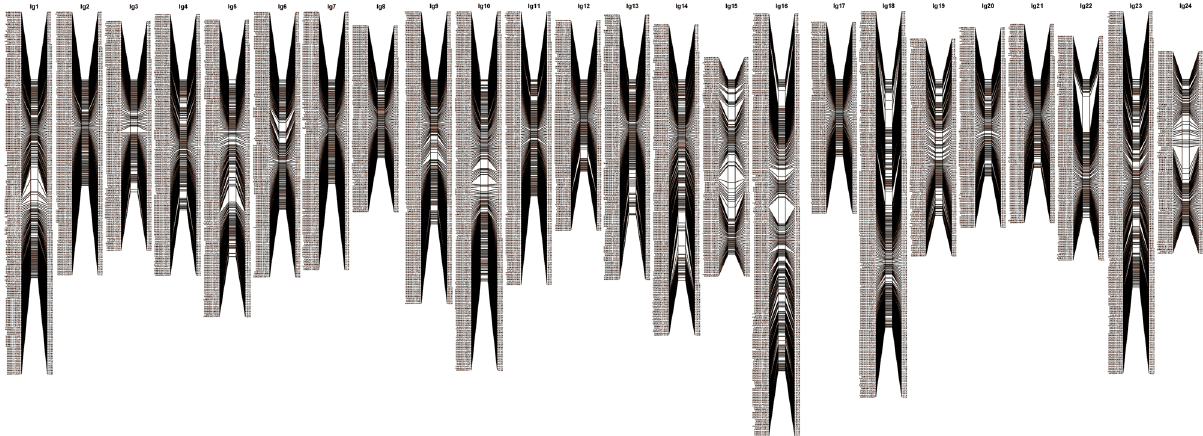
Figure 1. The consensus linkage map of L. polyactis. The consensus map which contained 3,802 effective SNPs in 24 linkage groups was constructed through combing the male and female linkage maps.